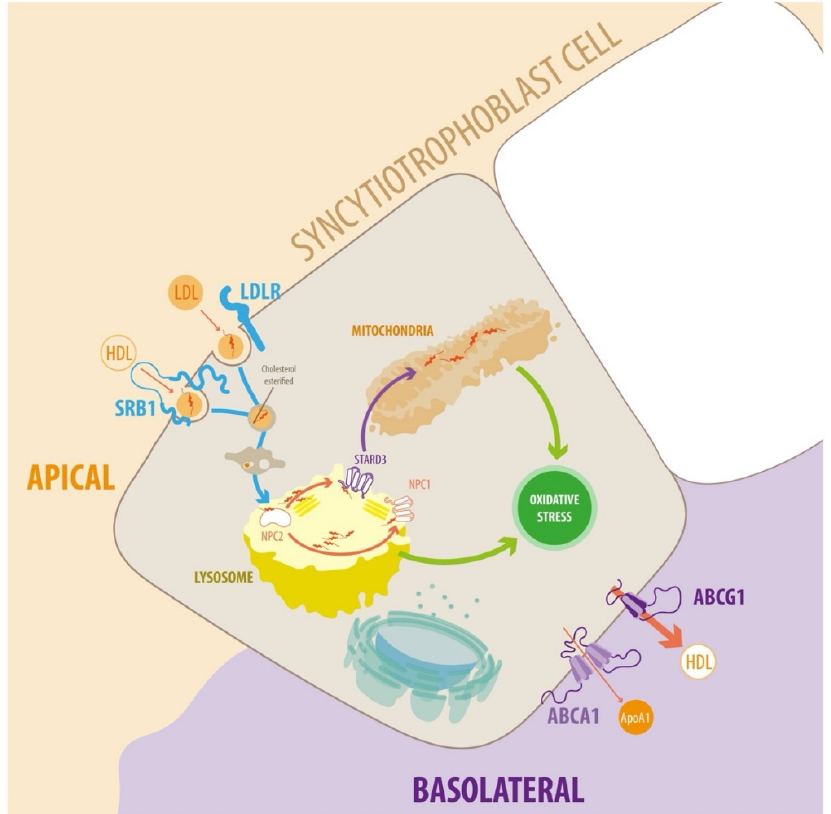
Figure 2. Diagram of endosomal cholesterol transport in the syncytiotrophoblast cells. In plasma, cholesterol is associated with different types of lipoprotein particles. LDL particles can interact with the plasma membrane of target cells via members of the LDLR family. The transfer of lipids between HDL and target cells is poorly understood. Several proteins and receptors bind HDL, such as SR-BI, which facilitates the uptake of cholesteryl esters. The receptor-ligand complexes dissociate after they enter acidic endosomal compartments. The receptors return to the plasma membrane, and lipoprotein particles enter the lysosomal pathway for degradation. Cholesterol incorporates into the endosomal/lysosomal membranes via NPC1 and NPC2. Cholesterol is transported to mitochondria for steroidogenesis via lipid transfer proteins such as STARD3. Cholesterol transport to other cellular targets, e.g., the plasma membrane, occurs via vesicular transport or cholesterol binding to various proteins. Alternatively, cholesterol can exit the STB via ABCA1 and ABCG1. ABCA1 stimulates cholesterol efflux to lipid-free apolipoproteins (predominantly ApoA-I, but also ApoE). Conversely, ABCG1 promotes the efflux of cholesterol and oxysterols to HDL. For detailed information, see